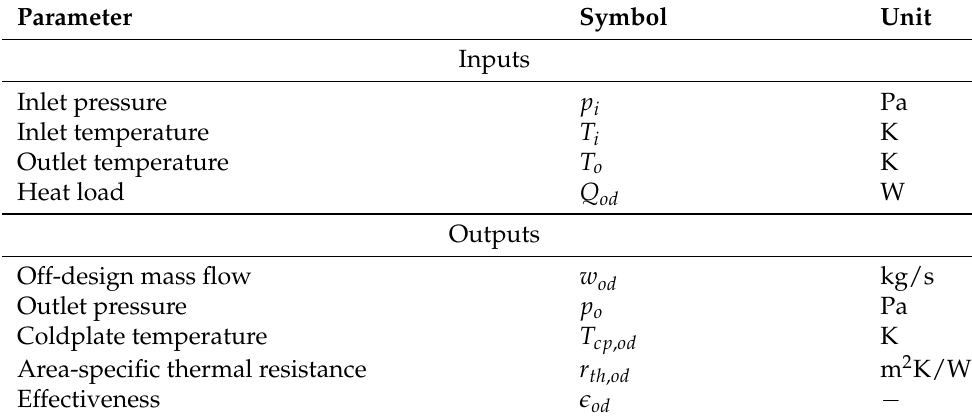
Table A2. Off-design parameters for the coldplate